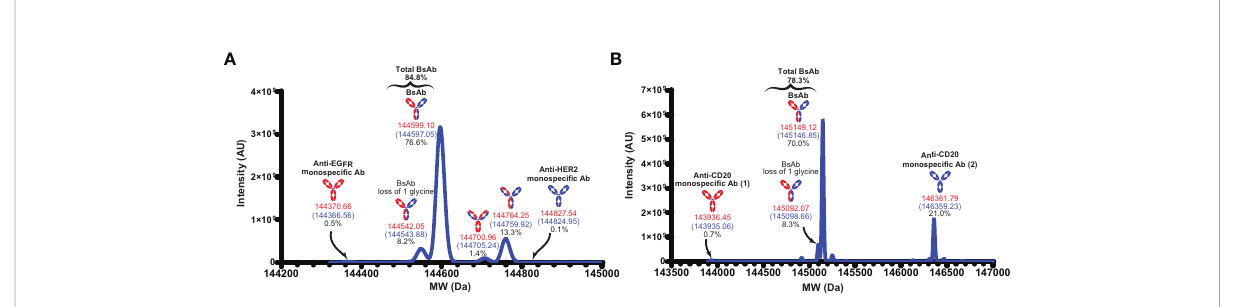
FIGURE 5 Intact mass analyses. (A) The deconvoluted MW of the anti-EGFR/HER2 BsAb. (B) The deconvoluted MW of the anti-CD20/CD20 BsAb. MWs in red indicate the theoretical mass with C-terminal lysine clipping and MWs in blue indicate the observed mass. Anti-CD20 monospeci fi c Ab (1) and anti-CD20 monospeci fi c Ab (2) contain Fab corresponding to rituximab and obinutuzumab monoclonal antibodies,